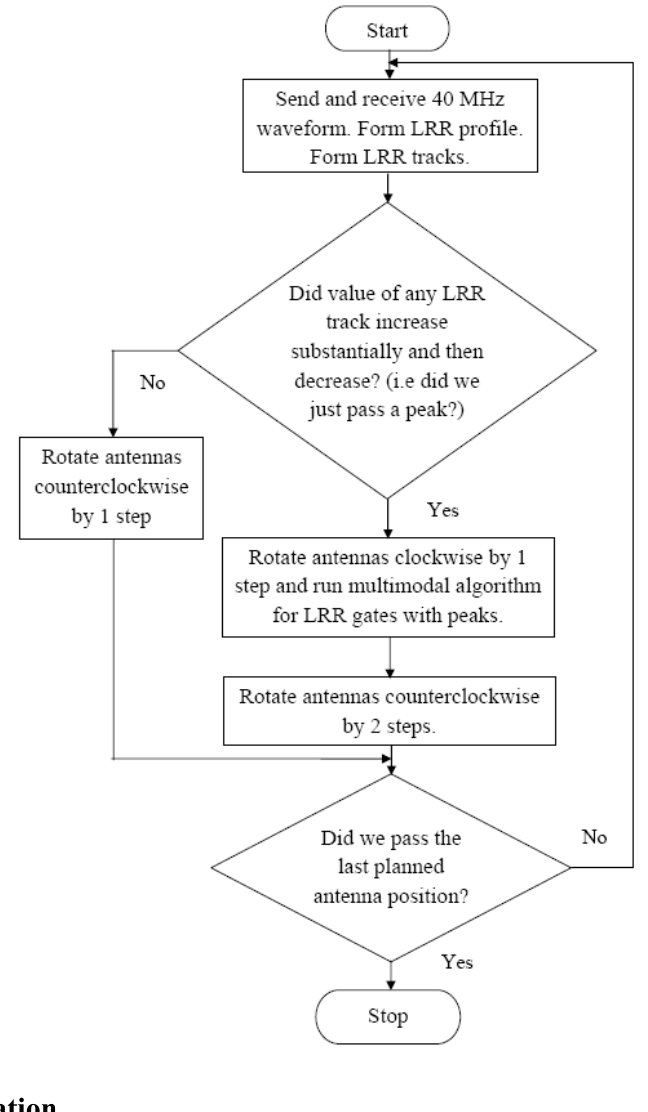
Figure 3. Flowchart for operation of multimodal radar in scanning